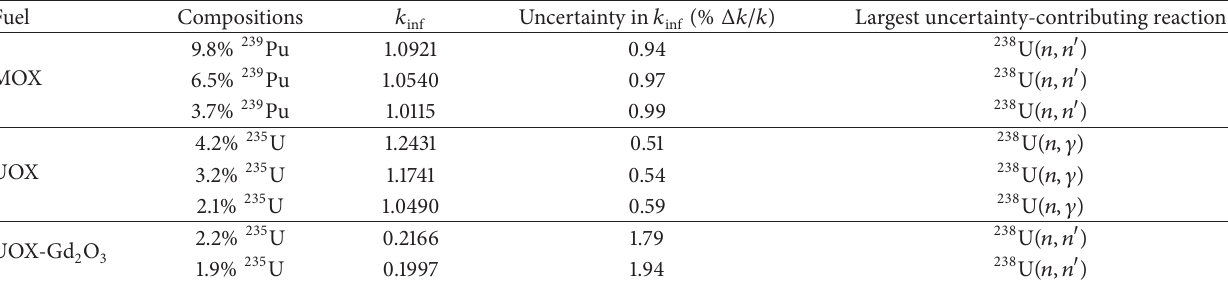
Figure 7: Plot of 239 Pu absorption cross-sections compared to 235 U absorption cross-sections. Table 4: Uncertainty in 𝑘 inf in GEN-III unit